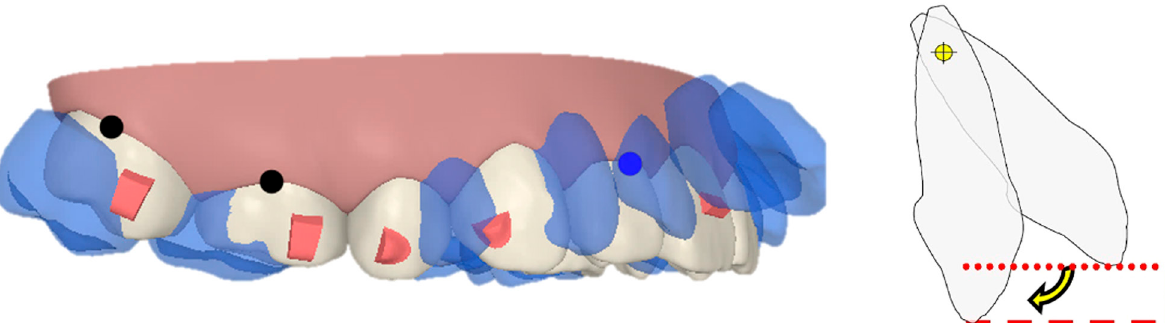
Figure 13. The ‘pendulum effect’ of the retraction of the anterior